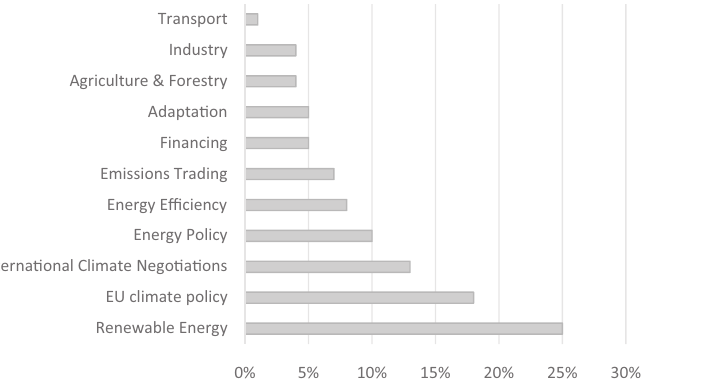
Figure 3. Stakeholders ’